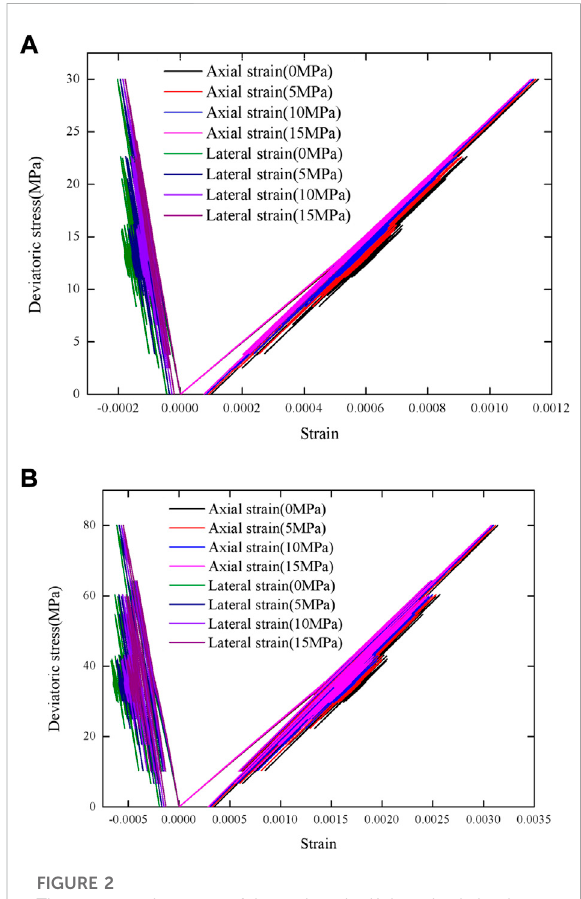
FIGURE 2 The stress-strain curves of the rock under Kobe seismic load with different con fi ning pressures: (A) Maximum stress of 30 MPa; (B) Maximum stress of 80 MPa.